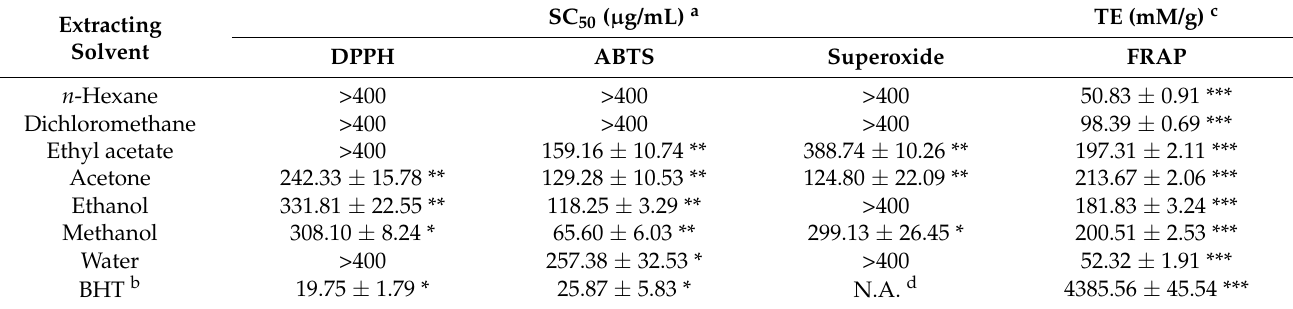
Table 2. The antioxidant activities of various solvent extracts from Morus alba L. determined by DPPH, ABTS, superoxide radical scavenging, and FRAP